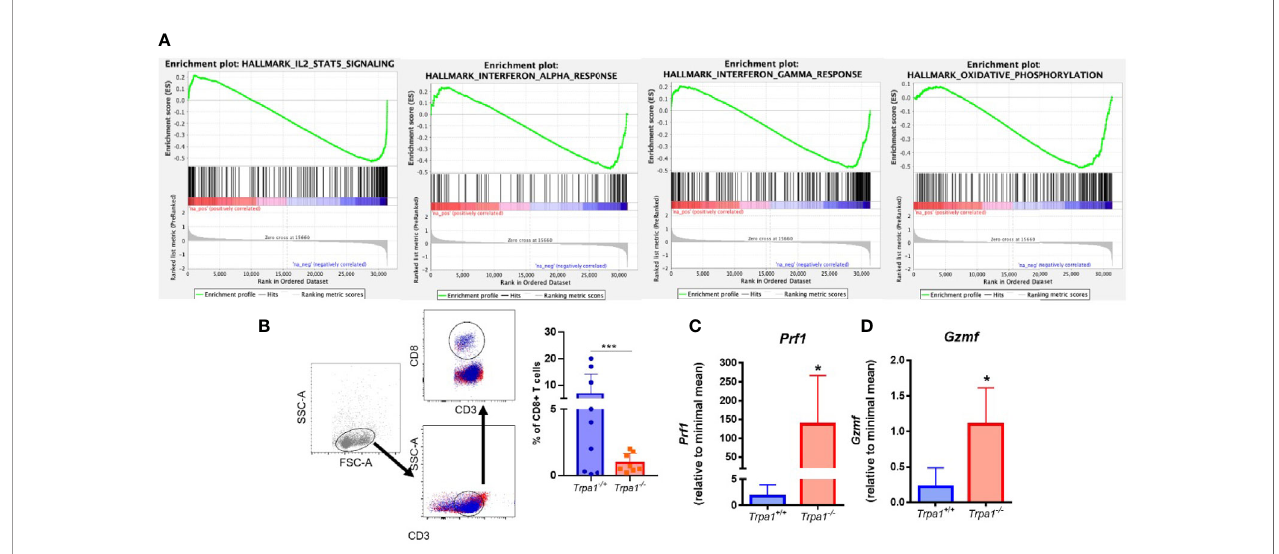
FIGURE 4 | (A) Analysis of transcriptome data of T CD8+ cells sorted from human patient tumors. We used GSEA to compare the changes in gene expression induced by CD3 activation in TRPA1 low and high cells. FDR-adjusted p values < 0.05 were considered statistically signi fi cant. IL-2 and Stat1 NES: -2,05246 and FDR: 1,00e-06; Oxidative phosphorylation NES: -1,9378266 and FDR 1,00e-06; IF gamma response NES: -1,8219428 and FDR 4,22e-04; IF alpha response NES: -1,6389698 and FDR 3,92e-03; (B) Gating strategy for the de fi nition of CD8+ T cell populations and analysis of frequency of in fi ltrating CD8 T cells in tumors from Trpa1 +/+ or Trpa1 -/- mice. (C, D) Bulk tumor mRNA isolation and qRT-PCR analysis 22 days after subcutaneous inoculation of B16-F10 cell inoculation; (C) Perforin mRNA relative levels; (D) Granzyme mRNA relative levels. Statistical analyses were performed by Student ’ s t -test. Values are presented as the mean (n = 9) ± SD of the frequency (%) in each group. *p < 0.05; ***p <